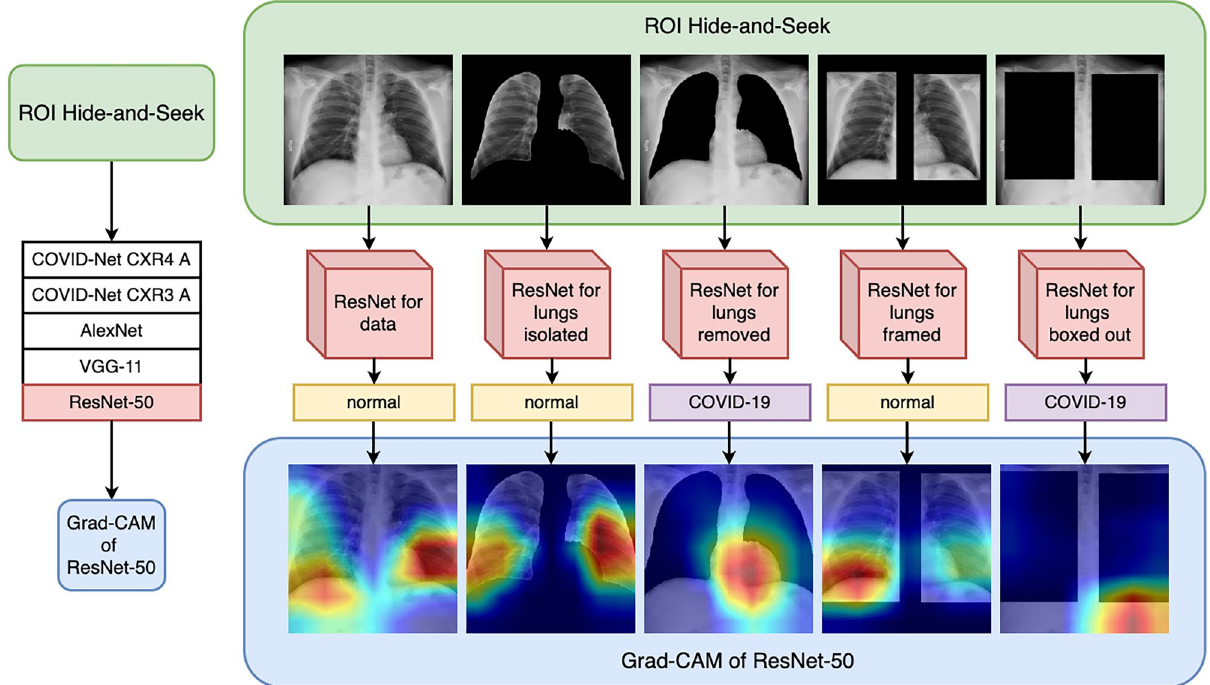
Figure 2. From raw chest X-ray to ROI Hide-and-Seek for validating deep learning